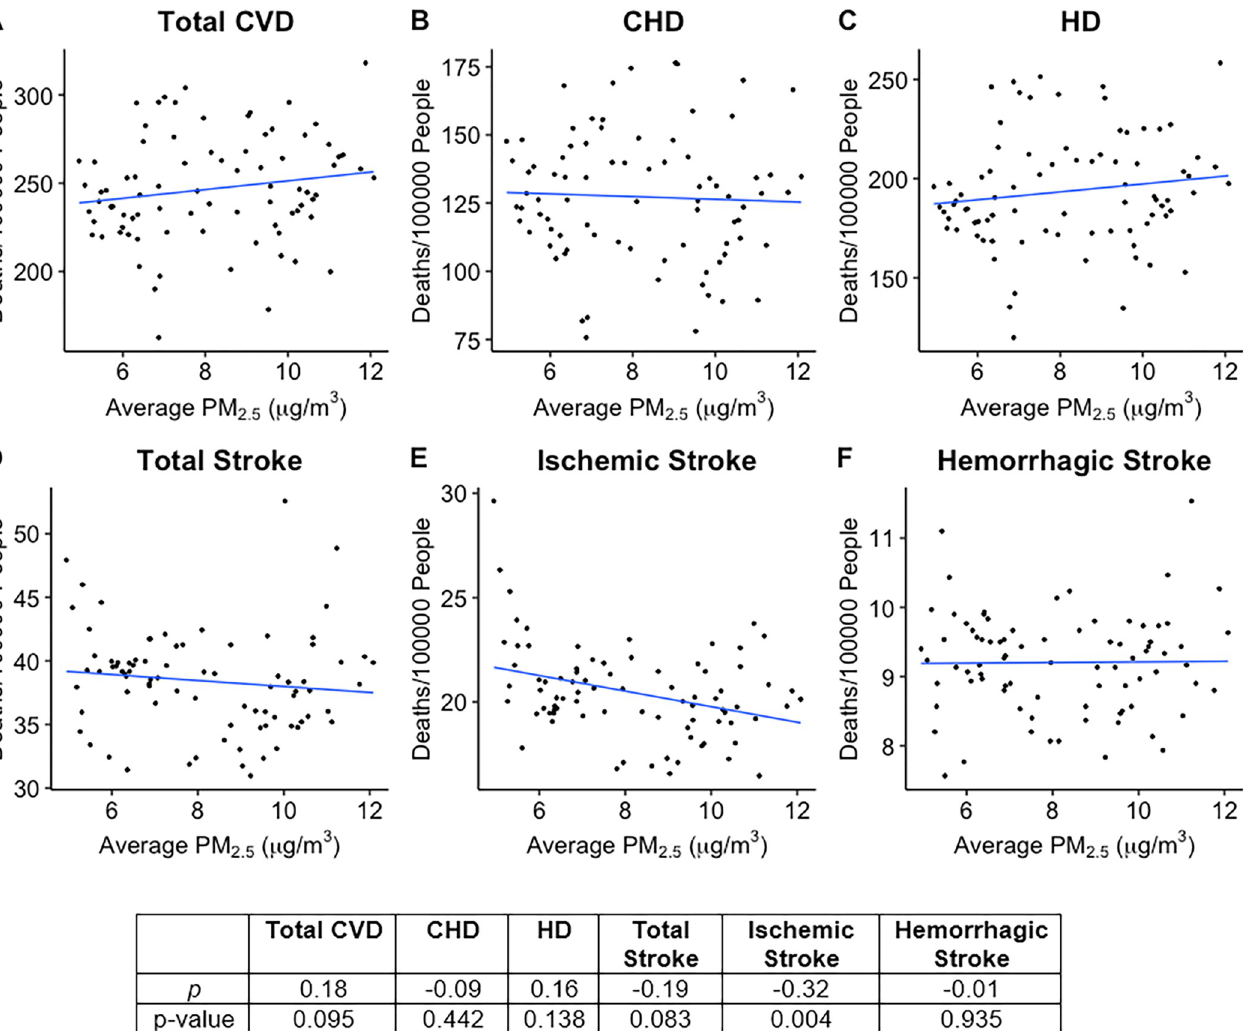
Fig 3. Scatterplots showing average PM 2.5 vs. death rate A. Total Cardiovascular Disease (CVD), B. Coronary Heart Disease (CHD), C. Heart Disease (HD), D. Total Stroke, E. Ischemic Stroke, and F. Hemorrhagic Stroke. Deaths have units: Disease deaths per 100,000 people within the county, regardless of ages or Medicare status (Y axis). Individual points represent values for each of the 82 counties included in the study. Best fit line for each plot obtained by simple linear regression. Table shows Spearman rank correlation coefficient ( ρ ) calculated for each plot as well as the p-value for each correlation coefficient. P-values < 0.05 are statistically